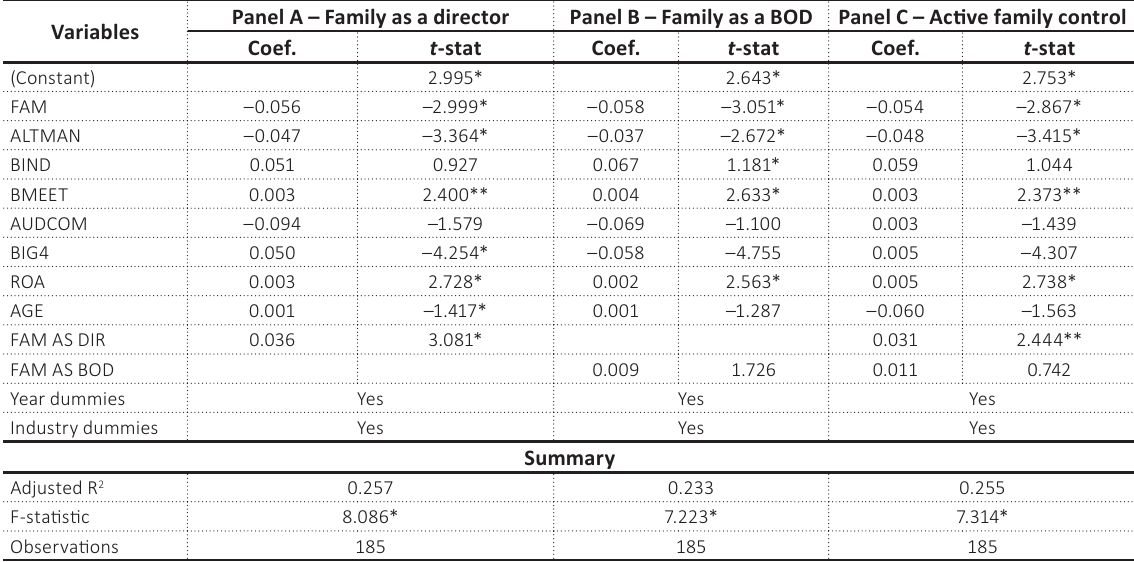
Table 6. Active family control and earnings management